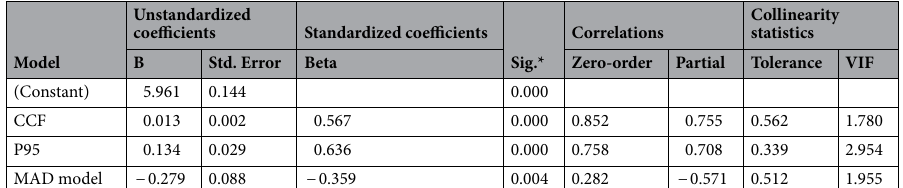
Table 8. The model coefficient and collinearity statistics of Model II—10 m radius plot.